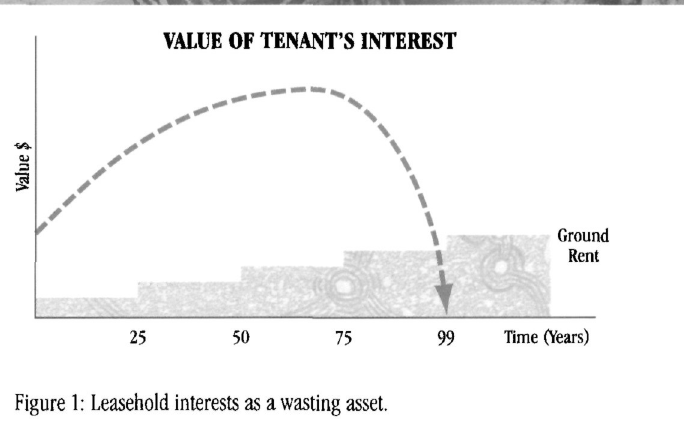
Figure 1: Leasehold interests as a wasting